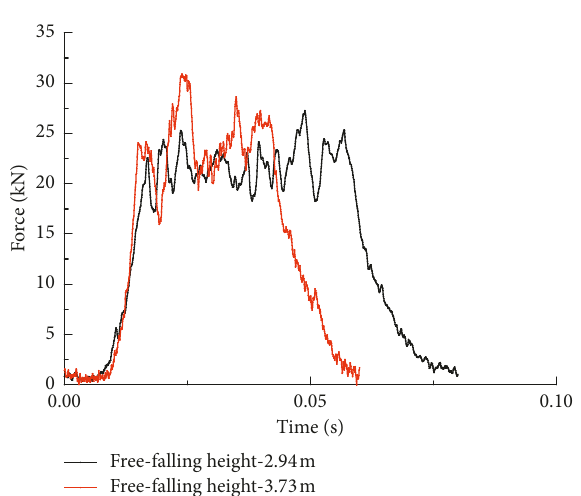
Figure 15: Dynamic load-time curves of the symmetric tube- crushing dissipators.